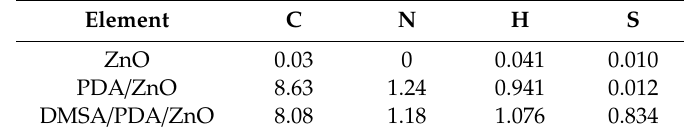
Table 1. Element (C, H, N, and S) contents (%) in ZnO, PDA / ZnO, and DMSA / PDA / ZnO.